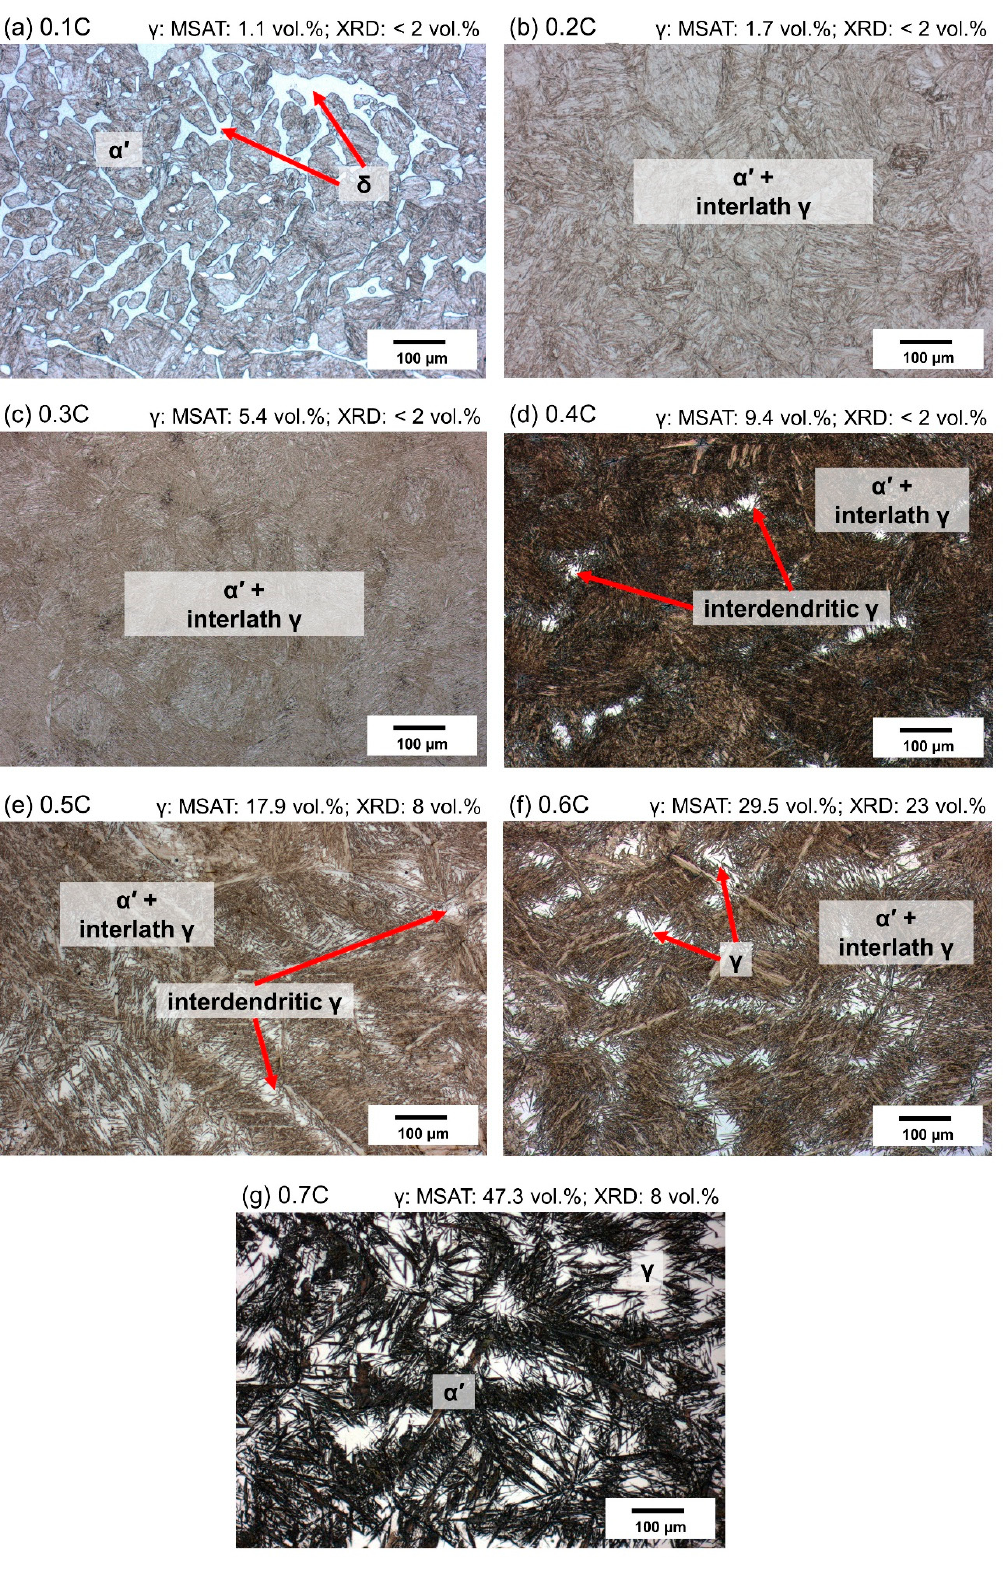
Figure 8. ( a – g ) Optical micrographs of 0.1C–0.7C alloys quenched to − 196 °C and etched with Beraha I solution. Numbers above optical micrographs denote phase fractions based on magnetic and XRD measurements, respectively.